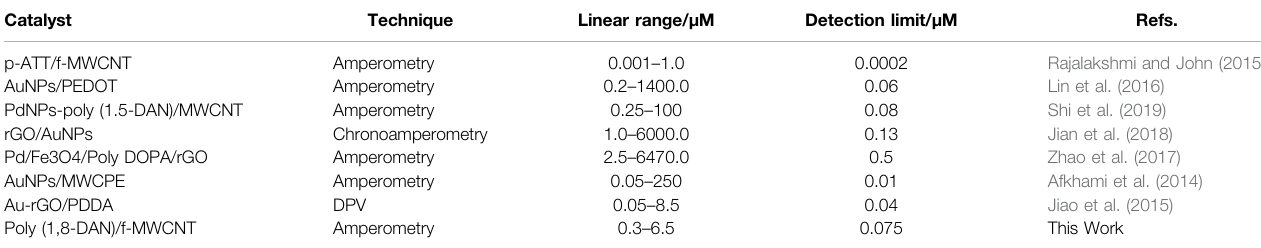
TABLE 2 | Comparison of the electrocatalytic performance of different hybrid materials.